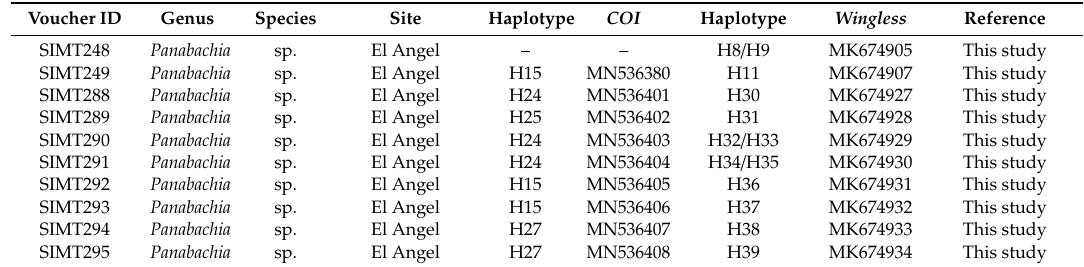
Table 2. GenBank accession numbers for voucher